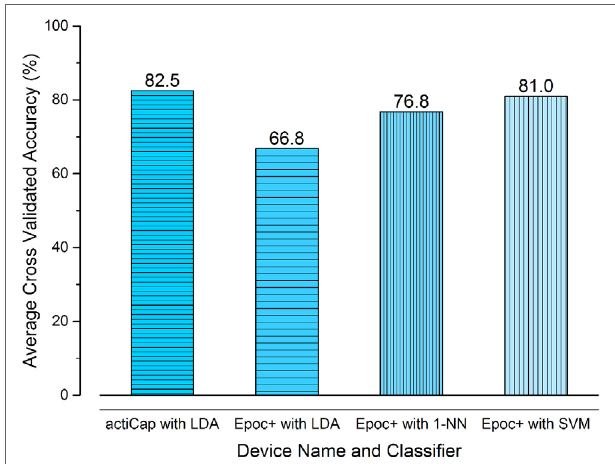
FigUre 8 | The results of using the acticaP and epoc + brain– machine interface systems . The average cross validated accuracy for four tests is shown. The actiCAP and raw Epoc + data [with standard openViBE preprocessing and linear discriminant analysis (LDA) classifier] show that the actiCAP gives 82.5% accuracy versus 66.8% for the Epoc + . On applying the preprocessing procedure (detailed in section 4) with two different classifiers, then the percentage cross-validated accuracy for the Epoc + system was improved to 76.8% (1-NN) and 81.0% (SVM). These results show that with appropriate preprocessing and classifier techniques then the cheaper Epoc + system can return data which is comparable to the much more expensive actiCAP